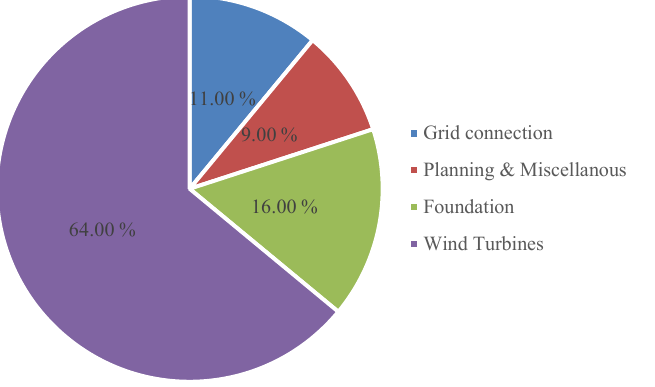
Fig. 3. Breakdown of costs for an onshore wind park in 2012